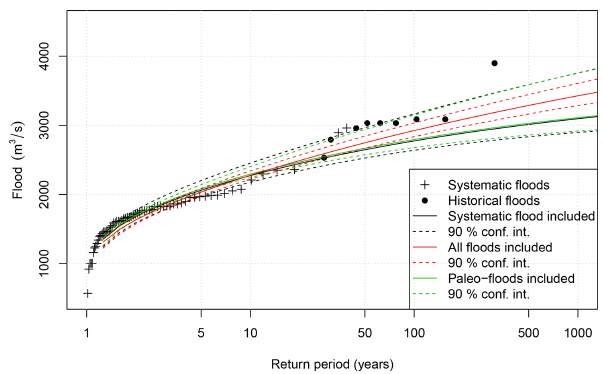
Figure 15. The sensitivity of flood frequency analysis to three dif- ferent combinations of systematic, paleo, and historical flood data. Annual maximum floods for the period 1872–1836 were used as systematic flood data. Paleofloods representing 208 events exceed- ing 1800m 3 s − 1 for the period 1300–1871. When all flood data were combined, the paleofloods represent 110 events for the pe- riod 1300–1652, and nine historical floods exceeding 2533m 3 s − 1 and representing the period 1653–1871 were used as historical floods. The plotting positions for the systematic and historical floods are based on Hirsch and Stedinger (1987) and explained in Sect. 3.4.2.